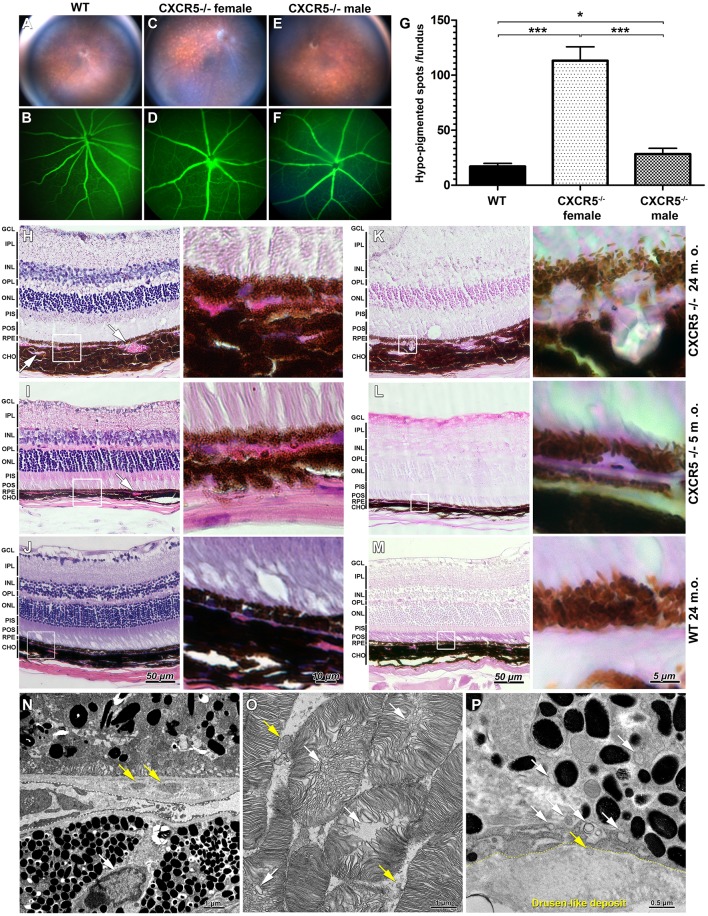
Fundus images and fluorescent angiography (FA) H&E, periodic acid Schiff (PAS) staining of CXCR5−/− and age-matched WT controls as well as transmission electron microscopy (TEM) of aged CXCR5−/− retinal pigment epithelia and retina. (A,B) Fundus images and fluorescent angiography of 24 m.o. female WT mouse; (C, D) 24 m.o. female CXCR5−/− mouse; (E, F) 24 m.o. CXCR5−/− male mouse; (G) Quantitative analysis of retinal hypo-pigmentation spots (n = 6). A one-way ANOVA test with Tukey multiple comparisons was used to determine statistical significance. *p < 0.05; ***p < 0.001. (H) H&E staining of 24 m.o. CXCR5−/−; (I) 5 m.o. CXCR5−/−; (J) 24 m.o. WT mice; (K–M) PAS staining of adjacent sections of the same eyes CXCR5−/−; Choroidal neovascularization is indicated by white arrows. The white square represents the enlarged RPE/choroid area of the respective image. Retinal layer designations: GCL, ganglion cell layer; IPL, inner plexiform layer; INL, inner nuclear layer; OPL, outer plexiform layer; ONL, outer nuclear layer; PIS, photoreceptors inner segments; POS, photoreceptors outer segments; RPE, retinal pigment epithelia; CHO, choroid. All histological samples were obtained from female mice. (N) Ultrastructural overview of retinal pigment epithelia, Bruch's membrane, and choroid of 24 m.o. female CXCR5−/− mouse; basal linear deposits are indicated by yellow arrows; the white arrow indicates a lymphocyte within the choroid near Bruch's membrane; (O) Photoreceptors—disruption of photoreceptors indicated by white arrows, and yellow arrows indicate that fragmented debris of the photoreceptors cells was present in intracellular space. (P) Sub-RPE drusen-like deposits ultrastructure—the yellow dotted line indicates the border of the deposit; the white arrows indicate vesicular structures; the yellow arrow indicates the vesicle entering the deposit.